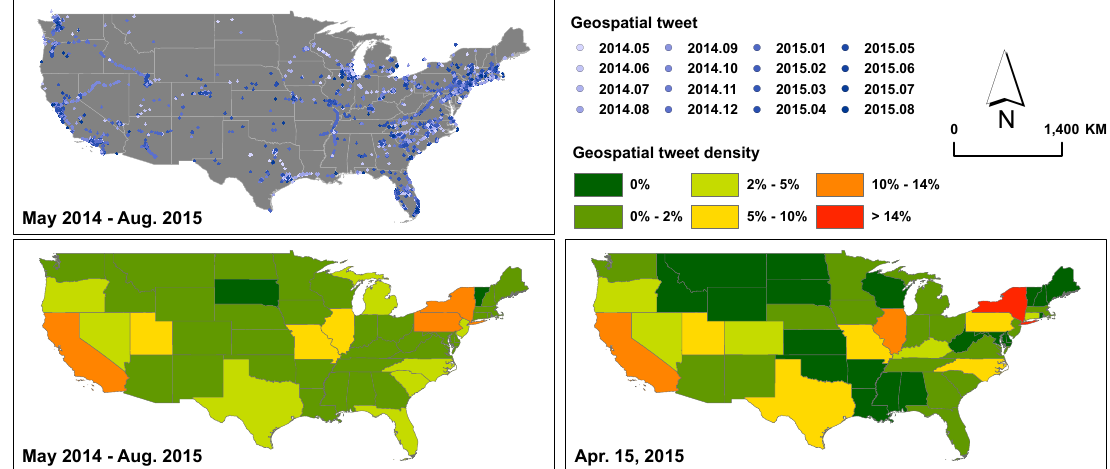
Figure 3. Maps of geospatial tweets related to the “Fight for $15” protest across the US continent.